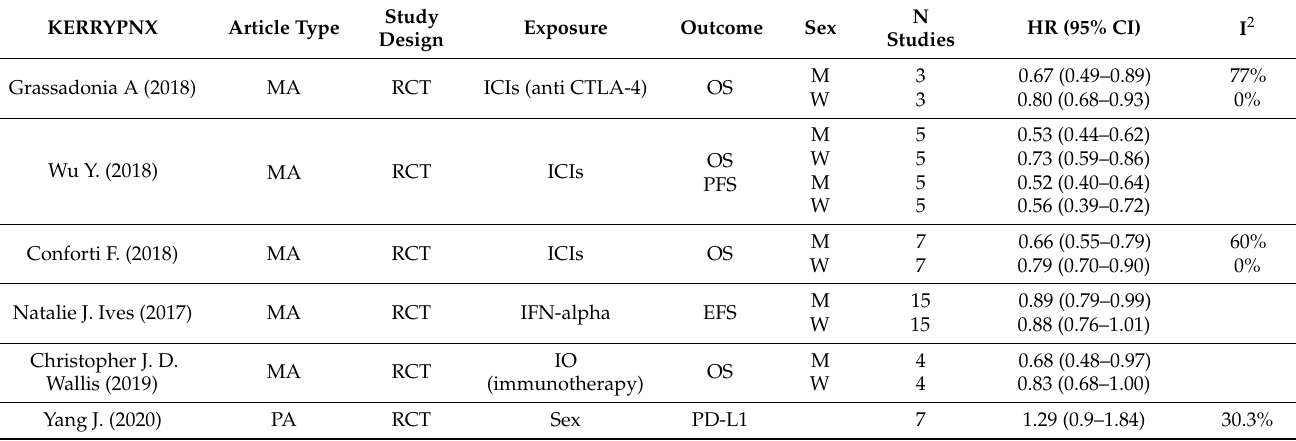
Table 2. Characteristics of studies investigating predictive